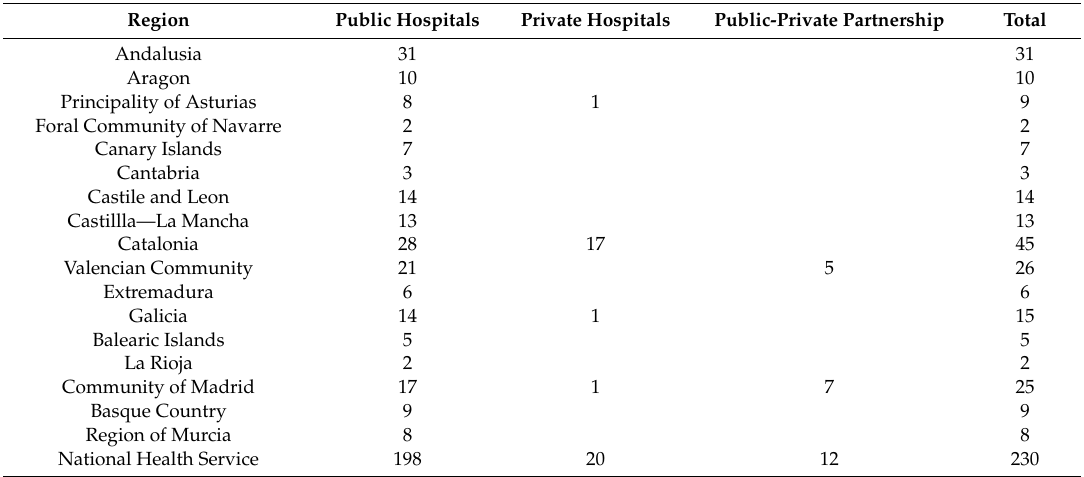
Table 1. Spanish National Health System general hospitals by ownership, structure and